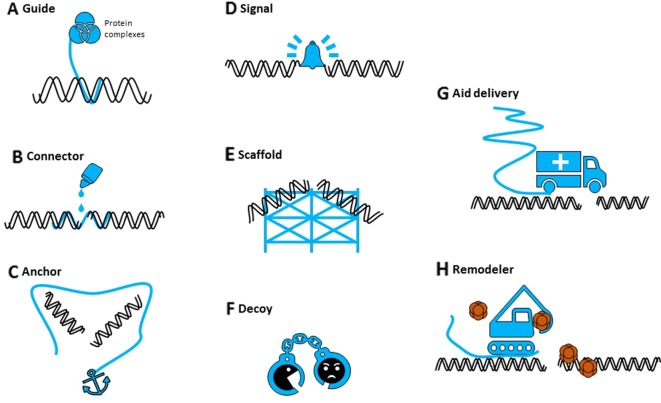
The different potential roles of noncoding RNAs in DNA repair. Noncoding RNAs (in blue) can (A) guide proteins to specific sites in the genome, (B) potentially hold broken ends together (connector), (C) mediate DNA-DNA or DNA-protein interactions (anchor), (D) serve as an indicator (signal) of DNA damage, (E) provide a repair scaffold, (F) keep interfering components away (decoy), (G) recruit repair proteins (aid delivery), or (H) initiate chromatin reconstruction (remodeler).